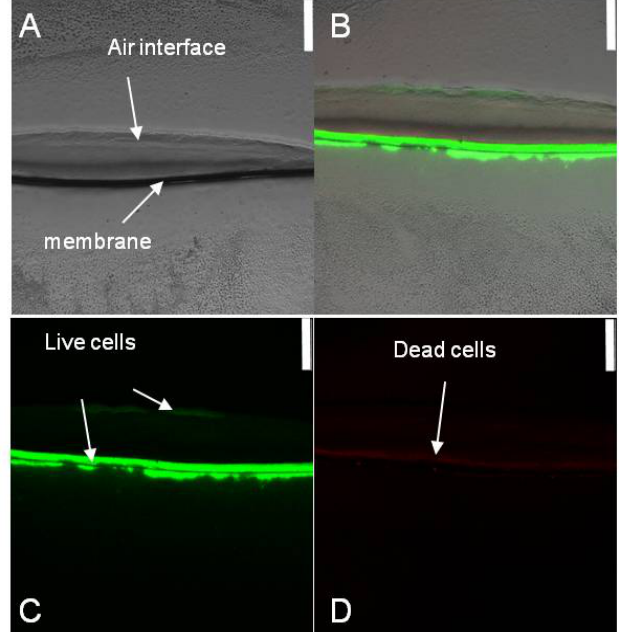
Figure 1. Spatial distribution of live and dead cells in Halothiobacillus HT1 biofilm reacted with CuS after dyeing and CLSM. ( A ) Light microscope images of Halothiobacillus HT1 biofilm; ( B ) a composite of live and dead cells; ( C ) live cells; ( D ) dead cells. Bars = 250 μ